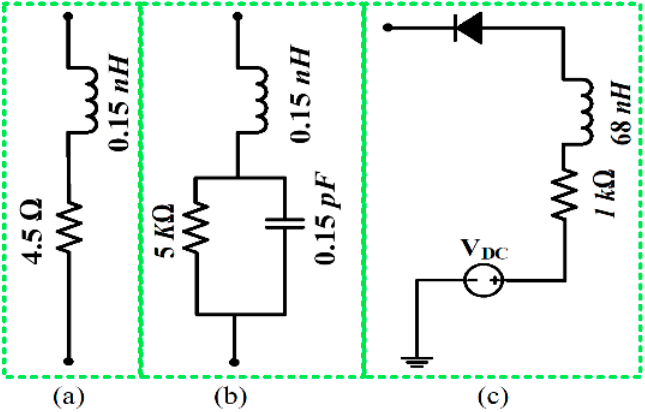
Figure 2. Diode equivalent model: ( a ) ON-state, ( b ) OFF-state, and ( c ) biasing circuit.